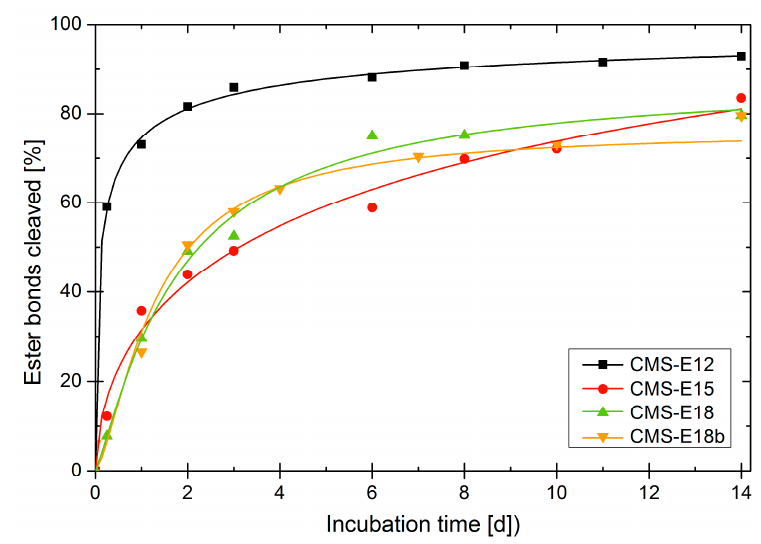
Figure 6. Comparison of the degree of hydrolysis for the ester bonds by lipase from Rhizomucor miehei as determined by NMR (DMSO-d 6 ), n = 1.